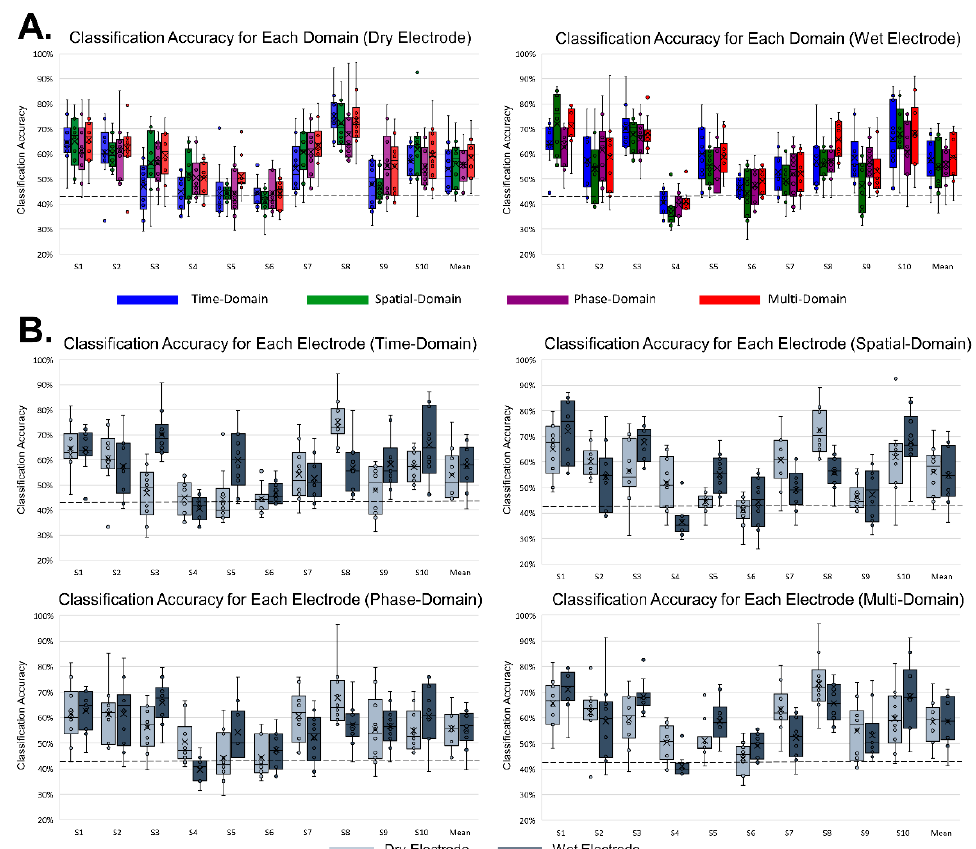
Figure 7. Classification accuracy of MD-CNN for all subjects. The boxplots with scatter points are drawn from 10-fold cross-validation results for each subject. The horizontal dotted line indicates the chance level. ( A ) Classification accuracy for each domain per electrode: time-domain (blue), spatial- domain (green), phase-domain (purple), and multi-domain representation (red). ( B ) Classification accuracy for each electrode for each domain: dry electrode (light blue); wet electrode (dark blue).